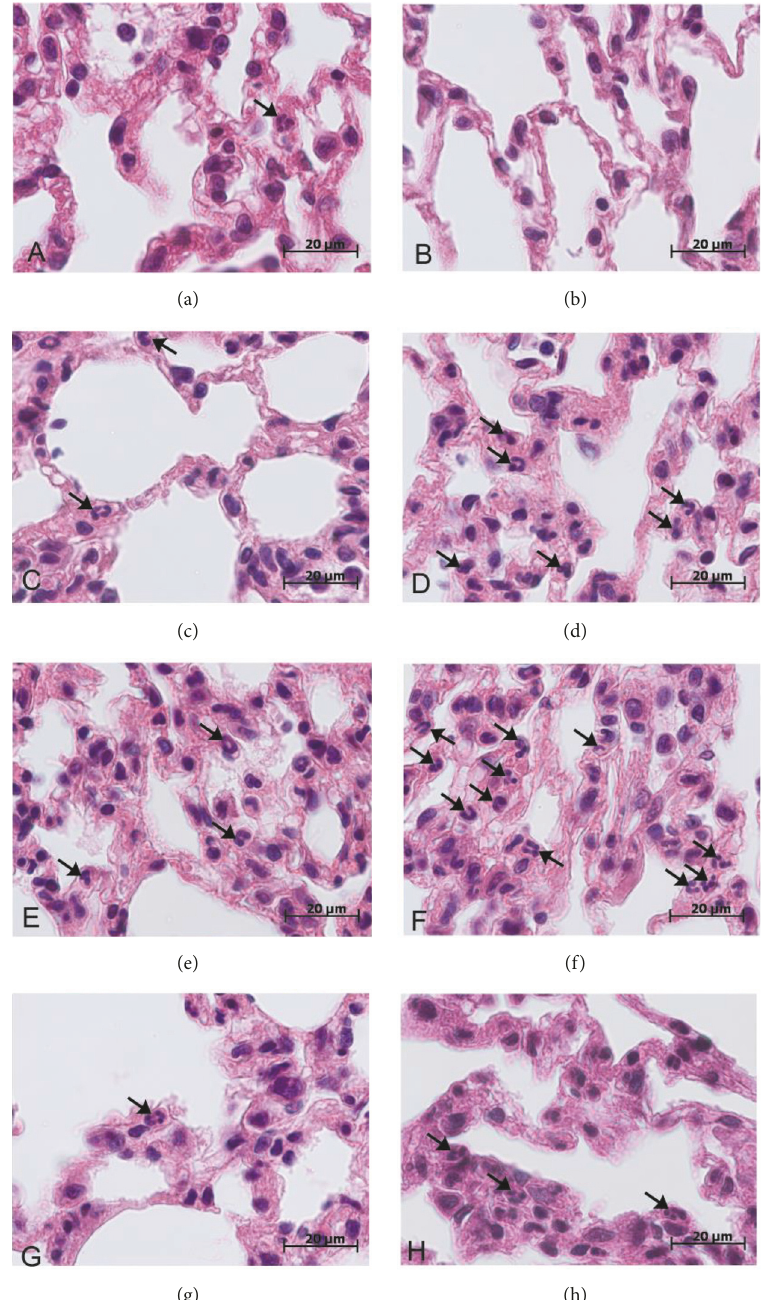
Figure 2: Morphological changes in the lungs of tolerant- and susceptible-to-hypoxia male Wistar rats after 3, 6, and 24 hours of LPS administration. Hematoxylinand eosin staining. Original magnification: ((a)-(h)) 1000x. Neutrophils are marked via arrows. (a) Tolerant-to- hypoxia rat, control group; few neutrophils in the field of view. (b) Susceptible-to-hypoxia rat, control group; thin interalveolar septa without neutrophils in the field of view. (c) Tolerant-to-hypoxia rat, 3 h LPS; interalveolar septa with neutrophils. (d) Susceptible-to-hypoxia rat, 3 h LPS; pronounced neutrophil infiltration in thickened interalveolar septa. (e) Tolerant-to-hypoxia rat, 6 h LPS; mild neutrophil infiltration in thickened interalveolar septa. (f) Susceptible-to-hypoxia rat, 6 h LPS; high number of neutrophils in thickened interalveolar septa. (g) Tolerant-to-hypoxia rat, 24 h LPS; interalveolar septa with few neutrophils. (h) Susceptible-to-hypoxia rat, 24 h LPS; interalveolar septa with